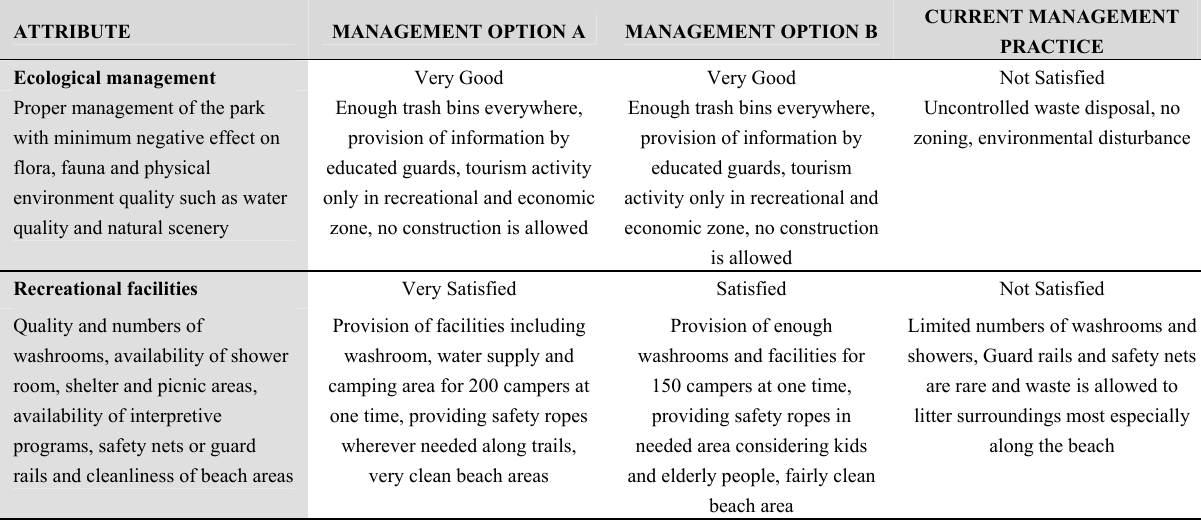
Table 2. Sample of choice